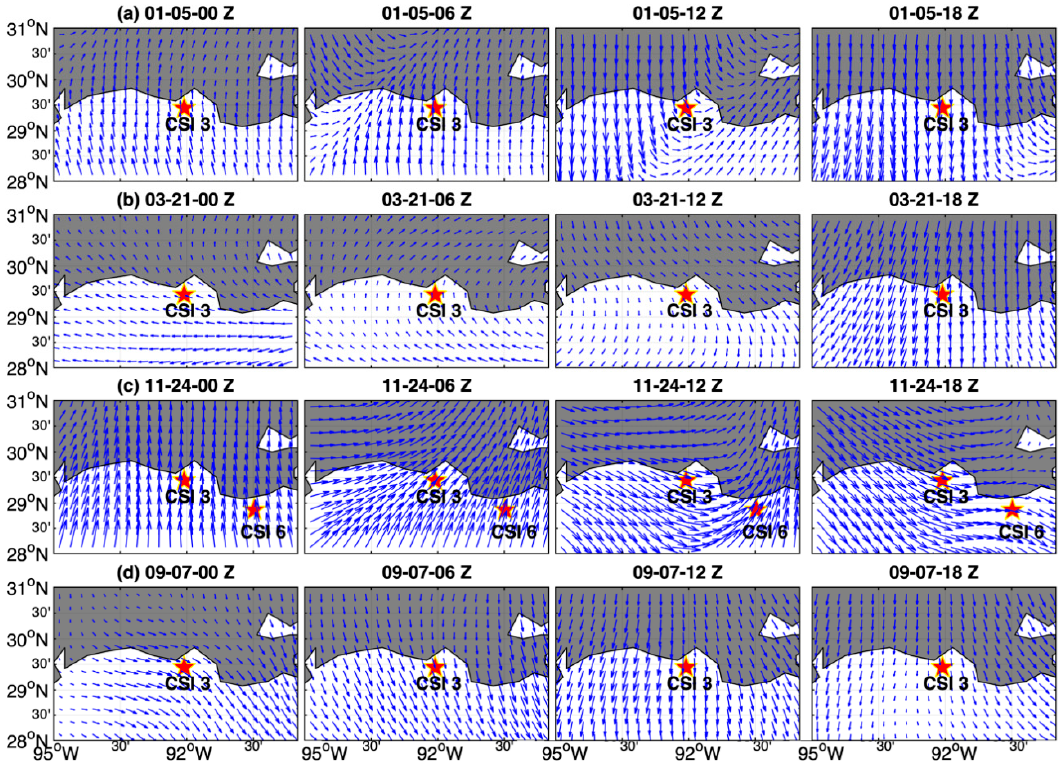
Figure 5. Spatial distribution of wind direction (blue arrows) from Cross-Calibrated Multi-Platform (CCMP) during the cold fronts passage for ( a ) Case I, ( b ) Case II, ( c ) Case III and ( d ) Case IV.